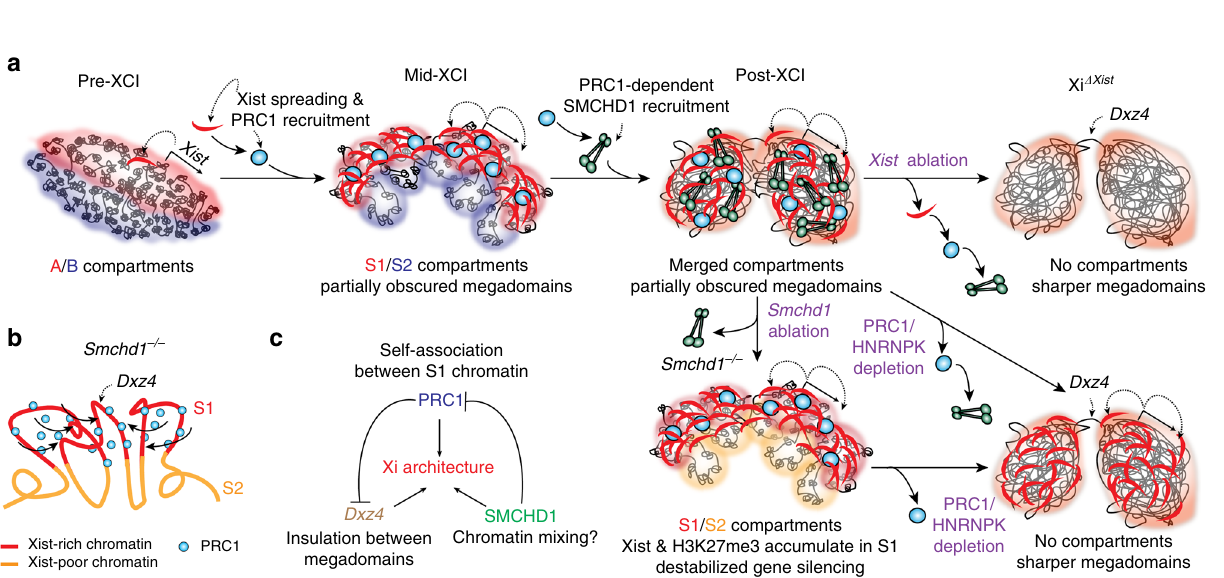
Fig. 7 Heterogeneous nuclear ribonucleoprotein K (HNRNPK) and polycomb repressive complex 1 (PRC1) mediate structural maintenance of chromosomes hinge domain containing 1 (SMCHD1) recruitment and the stepwise folding of the inactive X chromosome (Xi). a Immuno-RNA- fl uorescent in situ hybridization (immuno-RNA-FISH) for SMCHD1 and Xist on female wild-type mouse embryonic fi broblasts (WT MEFs) treated with small interfering RNA (siRNA) targeting HNRNPK, PRC1, and PRC2. Number of cells with SMCHD1 foci co-localizing with Xist clouds in a representative biological replicate is shown. Scale bar, 10 μ m. b Immuno-RNA-FISH for SMCHD1 and Xist on female WT MEFs treated with dimethyl sulfoxide (DMSO) or MG132. Number of cells with SMCHD1 foci co-localizing with Xist clouds in a representative biological replicate is shown. Scale bar, 10 μ m. c Chromatin binding pro fi les of H2AK119ub (GSE107217), H3K27me3 (GSE33823), and SMCHD1 (GSE99991) in female wild-type MEFs averaged over each 20-kb region centered at the summit of a H2AK119ub peak. d Depth-corrected chromatin interaction maps of the Xi in WT MEFs treated with control (scramble) siRNA, Smchd1 − / − MEFs treated with control siRNA, and WT MEFs treated with RING1A/RING1B (PRC1 knockdown (KD)) or HNRNPK (HNRNPK KD) siRNA binned at 200- kb resolution (top) and the corresponding Pearson ’ s correlation maps (bottom). Gray-shaded areas, unmappable regions. Also see Supplementary Fig. 13a for the active X chromosome (Xa) maps. e Principal component 1 (PC1) and PC2 values of the Xi. Regions with positive PC1 values represent the S1 compartment or the telomeric megadomain. Gray-shaded areas, unmappable regions. Also see Supplementary Fig. 13b for PCs of the Xa. f Bar plots displaying the fraction of long-range interactions (>10 Mb) that span the Dxz4 megadomain boundary ( “ inter-megadomain ” interactions) under different conditions. For HNRNPK KD, two replicates were analyzed, with P values determined by the t test (unpaired, one-sided). Error bars, s.d.